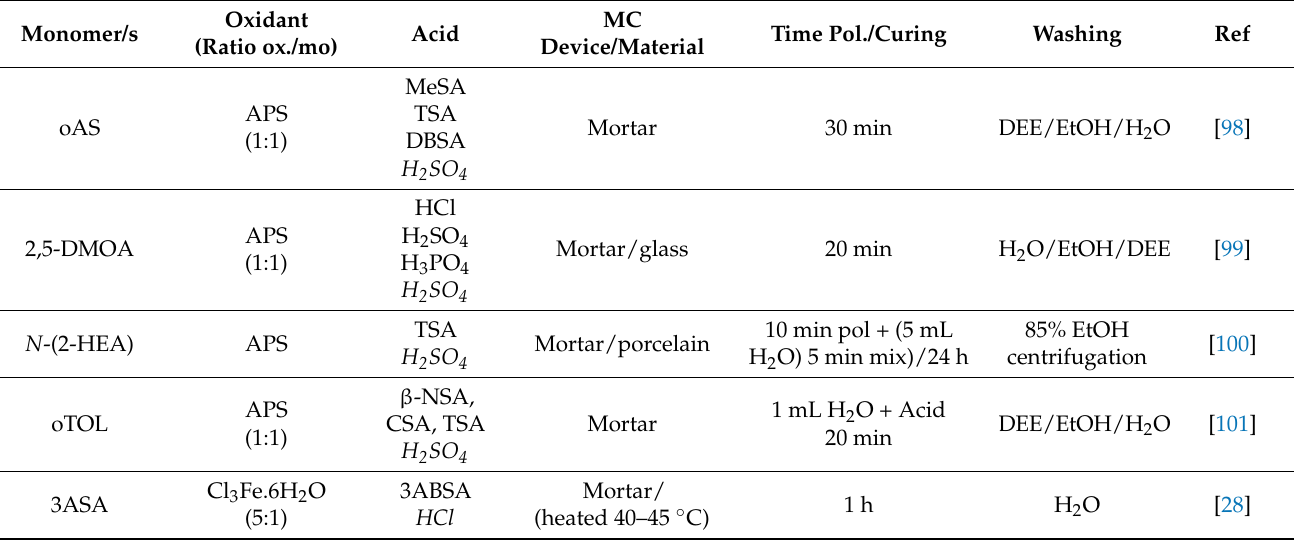
Table 3. Summary of reaction conditions for MCP of substituted anilines (linear chains). The acids produced in the reaction are shown in